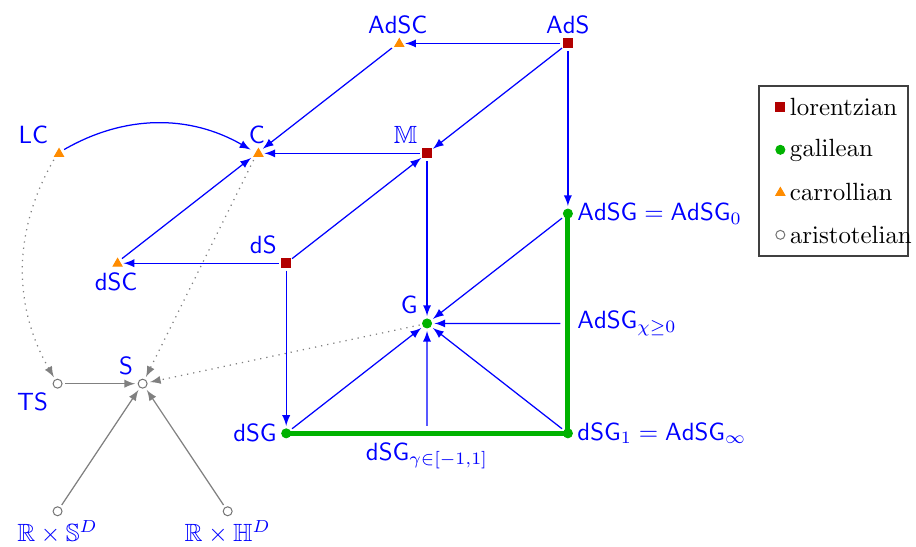
Figure 3 . Homogeneous spacetimes in dimension D + 1 (cid:21) 4 and their limits.